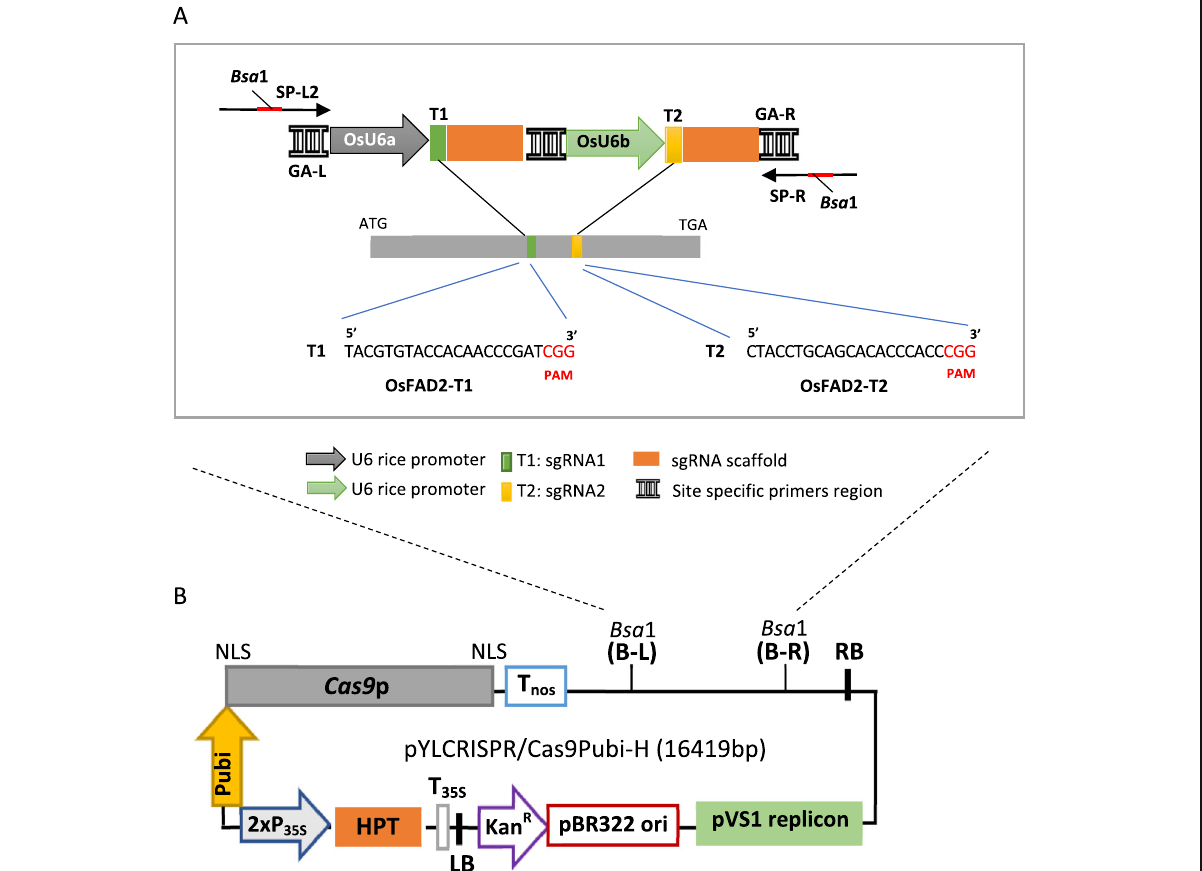
Fig. 3 Strategy for the construction of pYLCRISPR/Cas9 targeting OsFAD2-1 in rice. A Schematic illustration of target sites for two sgRNA expression cassettes driven by U6 promoters from rice; OsU6a promoter for OsFAD2-T1 and OsU6b promoter for OsFAD2-T2, the 20-nt sequences in green square boxes and orange square boxes indicate the PAM motif of each sgRNA, the Bsa I restriction enzyme sites for the entry of multiple sgRNA expression cassettes, SP-L2 and SP-R are sequencing vector-specific primers, GA-L and GA-R are GA site-specific primers for the Gibson assembly of sgRNA T-DNA, T35S: cauliflower mosaic virus 35S terminator, HPT : gene for hygromycin phosphotransferase, 2xP 35S : Double cauliflower mosaic virus 35S promoter, P ubi : maize ubiquitin Ubi1 promoter, NLS: Nuclear localization sequence. Cas9 p: CRISPR associated protein 9, Nos : nopaline synthase gene terminator, RB: right border of T-DNA, pVS1 replicon: pVS1 for replication, pBR322: pBR322 vector, Kan R : Kanamycin resistance